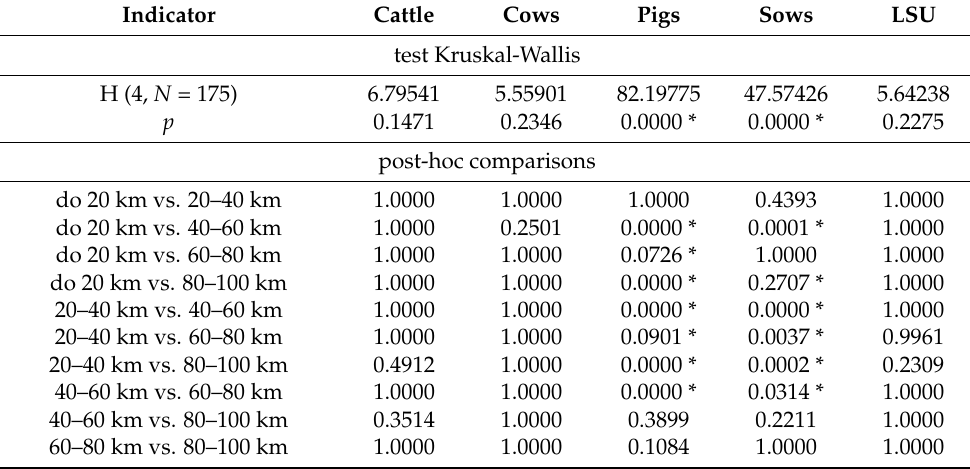
Table 4. The results of the Kruskal-Wallis multiple comparisons test * performed to analyze the dynamics of the changes in livestock (according to the data from the districts).